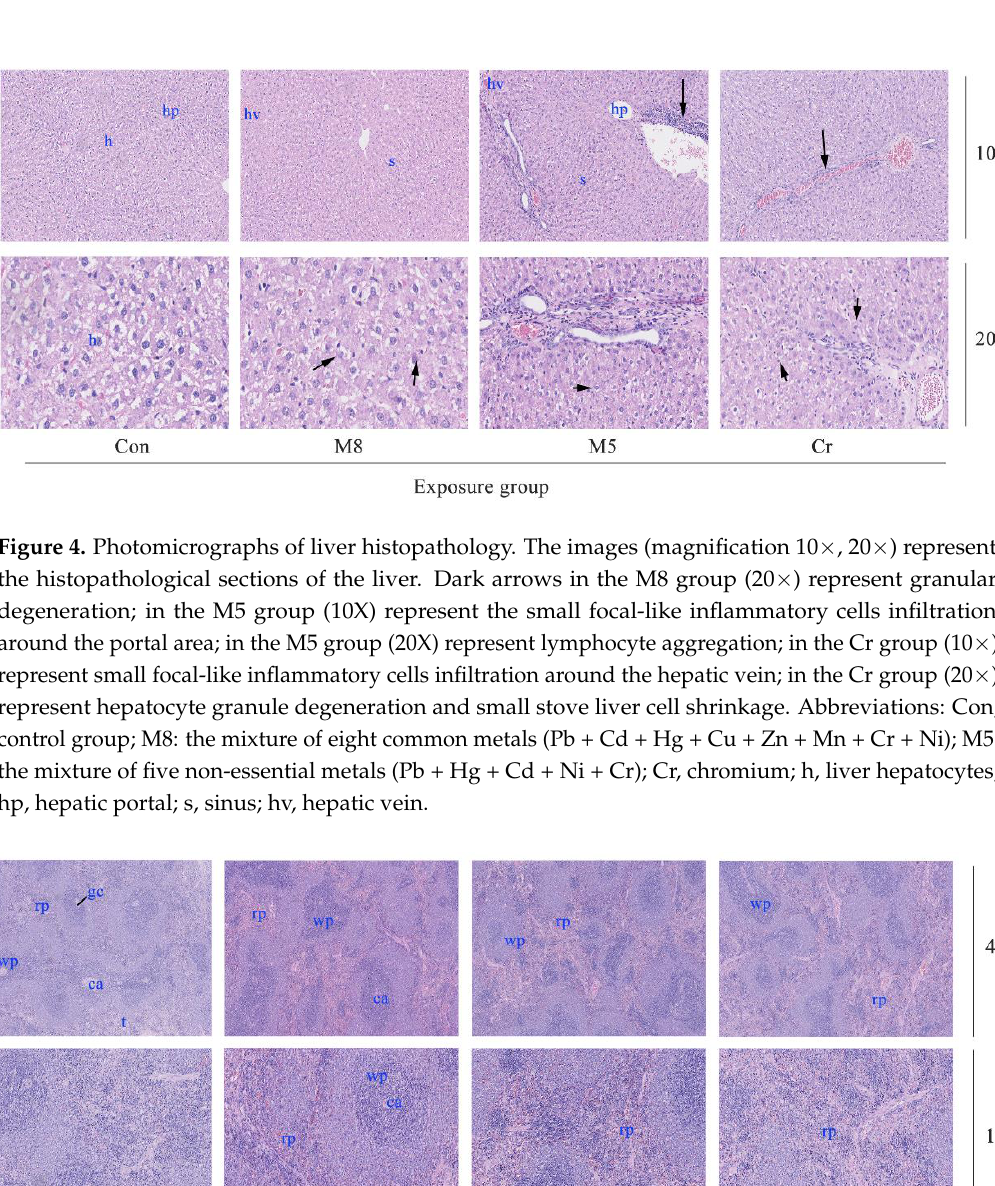
Figure 6. Photomicrographs of kidney histopathology. The images (magnification 4×, 20×) represent the histopathological sections of the kidney. M8 group and Cr group (20×), large areas of renal tubular epithelial cells were cloudy and swollen, significant degeneration, vacuolar degeneration of the membrane (dark arrow). M5 group (20×) a large number of inflammatory cells infiltration (dark arrow). Abbreviations: Con, control group; M8: the mixture of eight common metals (Pb + Cd + Hg + Cu + Zn + Mn + Cr + Ni); M5: the mixture of five non-essential metals (Pb + Hg + Cd + Ni + Cr); Cr, chromium. 3.5. Western Blot Analysis Western blot analysis of the expressions of JNK, p-JNK, p38, NFκB, Nrf2 and Akt proteins were carried out on small sections of the brain tissue (Figure 7). There was a significant decrease in the